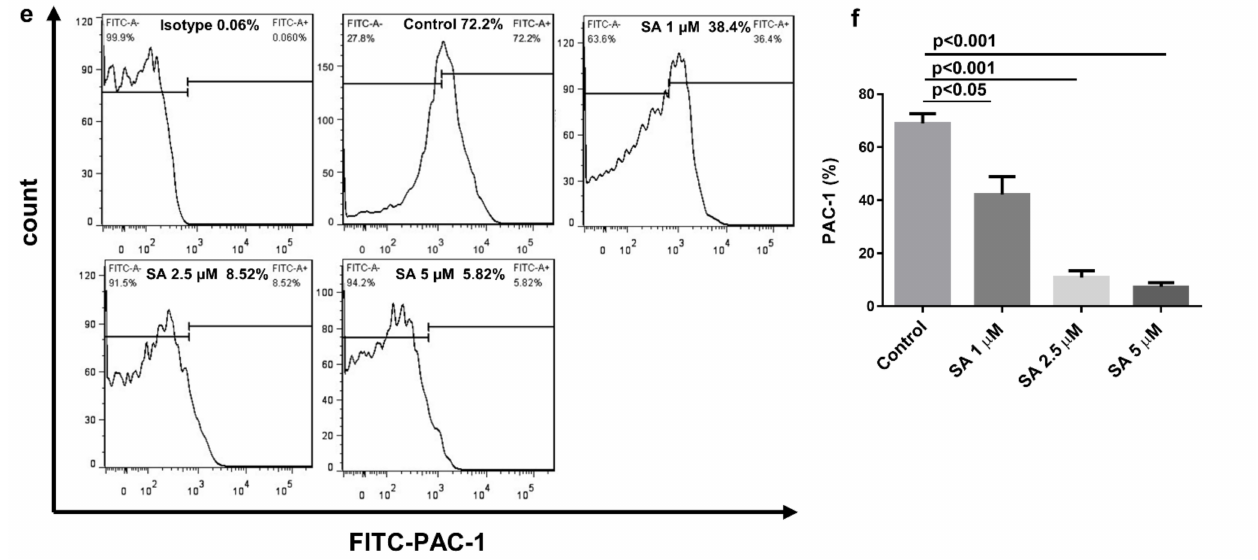
Figure 4. Sanguinarine decreases collagen-induced human platelet granule release and integrin α IIb β 3 activation. ( a ) Washed human platelets were prepared as shown in Figure 3. ATP secretion was documented and computed following the instructions in the Materials and Methods Section. ( b ) Data were shown as mean ± SEM ( n = 5) and examined using one-way ANOVA analysis. ( c – f ) First, washed human platelets (5 × 10 7 /mL) were preincubated for 10 min at 37 ◦ C with sanguinarine (1, 2.5, 5 µ M) or DMSO (control) in the presence of FITC-conjugated P-selectin and FITC-conjugated PAC-1 antibodies. Afterward, the platelets were stimulated with collagen (2 µ g/mL) and incubated for another 5 min. P-selectin expression ( c , d ) and PAC-1 binding ( e , f ) were identified by flow cytometry. Results and data were expressed as mean ± SEM ( n = 5).